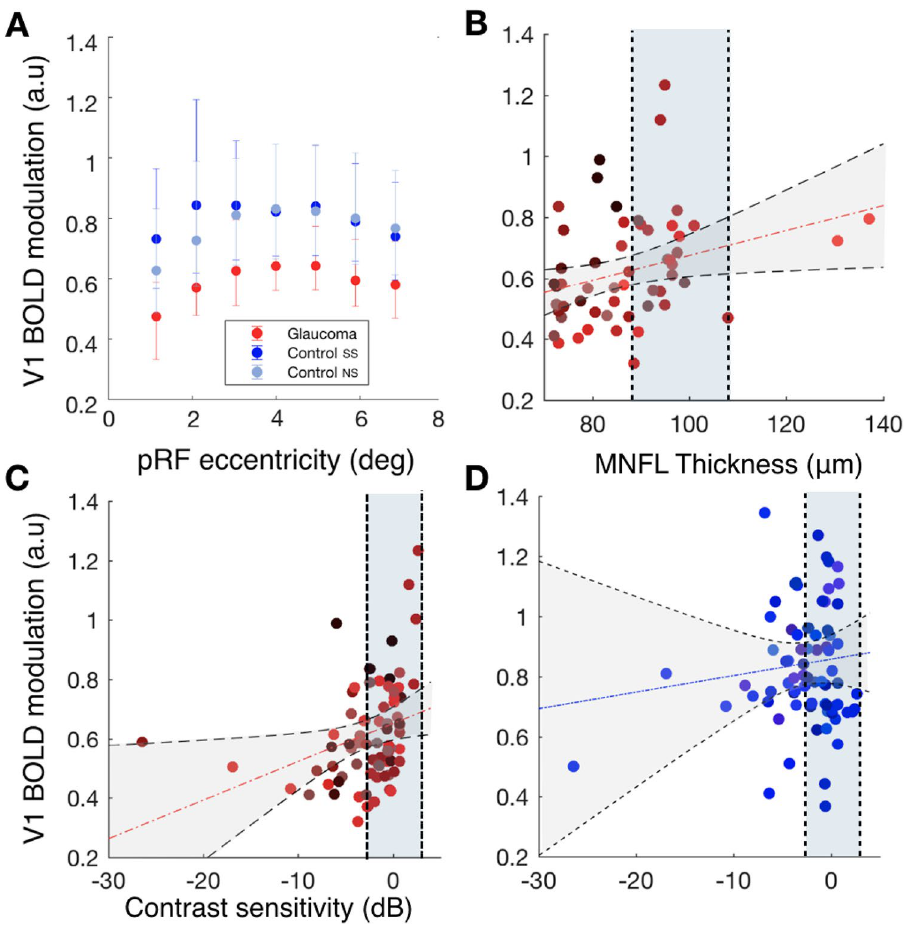
Figure 1. V1 BOLD modulation varies between participants with glaucoma and control participants and correlates with disease severity. ( A ) V1 BOLD modulation, defined as a function of eccentricity for glaucoma (red) and control participants with (dark blue) and without a simulated scotoma (light blue). The BOLD modulation was binned in 1° eccentricity bins. The bars represent the 95% confidence interval (CI). ( B ) Correlation of the V1 BOLD modulation of participants with glaucoma obtained from individual quadrants with MNFL thickness (calculated by averaging the values of the macula of both eyes). Each data point is from a separate quadrant of an individual participant with glaucoma. The different shades of red and blue colors denote the different Glaucoma and Control participants, respectively. ( C , D ) Correlation of the V1 BOLD modulation from separate quadrants with the contrast sensitivity of both eyes combined (the max between the mean deviation of the two eyes) for glaucoma and controls, respectively. Each data point is from an individual VF quadrant. The vertical dashed lines and shaded blue area represent the average values ± SD of the MNFL thickness (plot B ) and contrast sensitivity (plots C , D ) measured in control participants, Table 1. The correlations between the BOLD modulation and the disease severity (contrast sensitivity and MNFL thickness) were calculated using a linear mixed effects model with a slope and intercept per subject as a random effect. Detailed information regarding the correlation analysis is provided in “Correlation